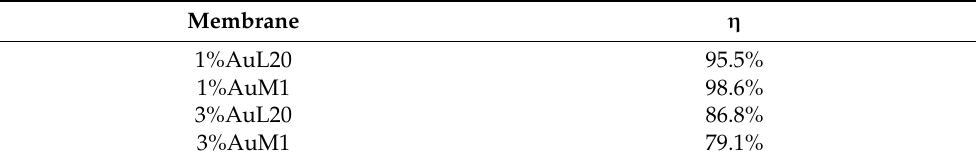
Table 5. Encapsulation